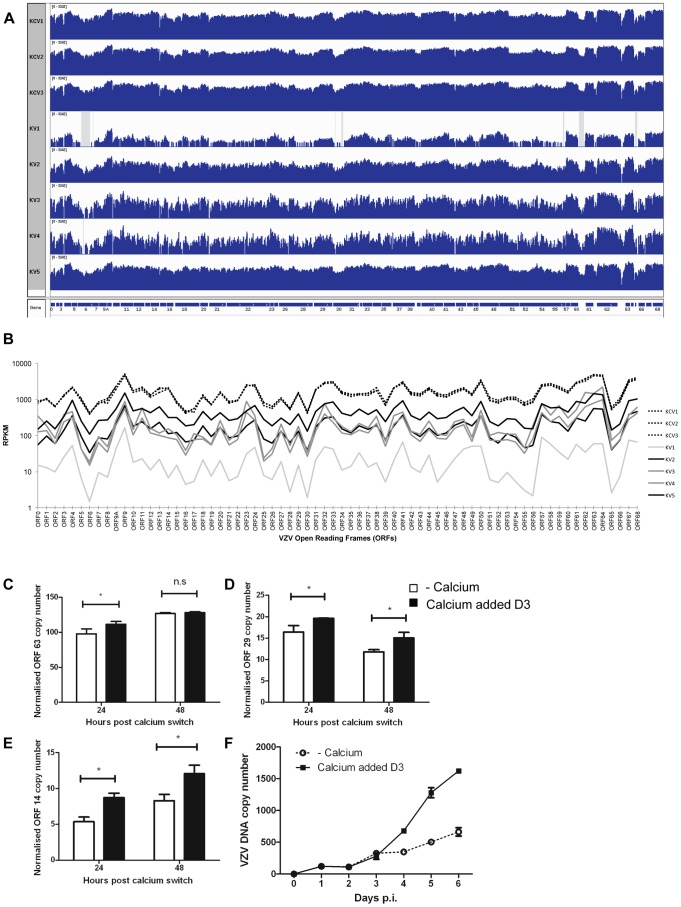
Epidermal differentiation increases VZV transcription.
A) Coverage plots of viral RNA-seq reads mapped to the annotated VZV pOka genome. The top three panels represent KCV1–3 samples and the lower 5 samples are KV1–5. A schematic representation of the VZV open reading frames is shown below. Each coverage plot uses an identical log scale, illustrating the higher degree of coverage in the KCV samples. Regions with zero coverage are shaded grey. B) RPKM values for each of the VZV ORFs across the infected samples. The RPKM values are normalised relative to the sum of human and viral reads per sample. The pattern of expression is similar across all samples with RPKM values for each ORF being greater than 1 in every sample. RPKM values for the KCV samples are less variable than those for the KV samples with a median 9-fold upregulation per ORF (KCV/KV, range 4–15 fold upregulation, all ORFs significantly upregulated with pFDRs<0.01). RPKM values for KV1 are noticeably lower than all other samples. At day 5 p.i., 48 hrs after the addition of calcium, the levels of three VZV genes were determined by qPCR and normalised to the housekeeping gene RN5S, no amplification was seen in the mock infected controls (data not shown). The upregulation of KRT10 in the uninfected controls was used as a marker to ensure that the addition of calcium had caused keratinocyte differentiation (data not shown). The expression of (C) ORF63 (IE) ORF29 (early) and ORF14 (late) genes was determined (n = 3) and plotted. Expression of ORF29 (D) and ORF14 (E) was significantly increased after the addition of calcium, *p<0.05 by Student's t-test. F) The rate of vDNA replication, as measured by qPCR increases after the addition of calcium (at 48 hrs) in the differentiated cells (n = 3, ± stdev).